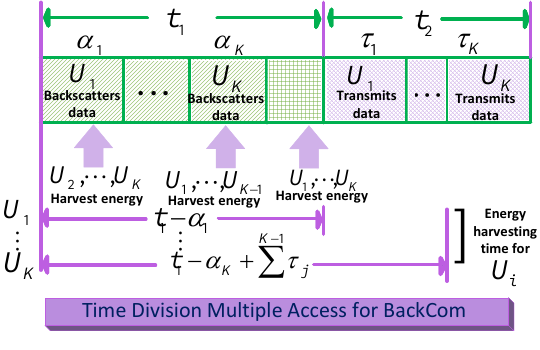
Figure 25. TDMA in